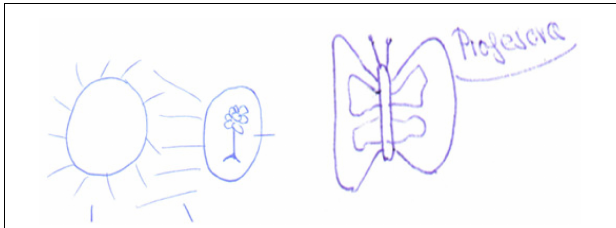
FIGURE 10 | Drawing of the teacher as a guide dog and guiding and protecting fledgling birds.